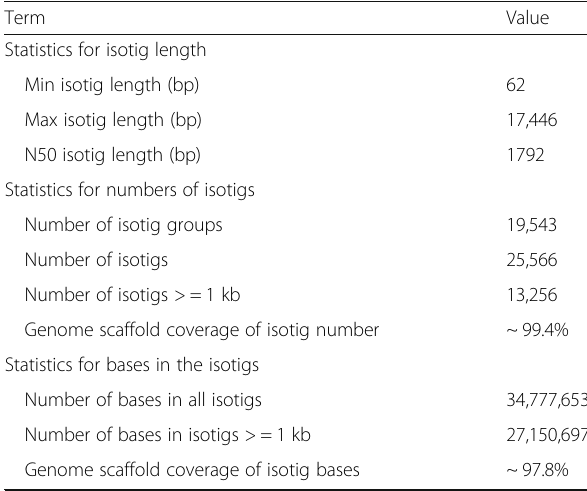
Table 3 Summary of the D. japonica transcriptome assembly and genome scaffolds coverage